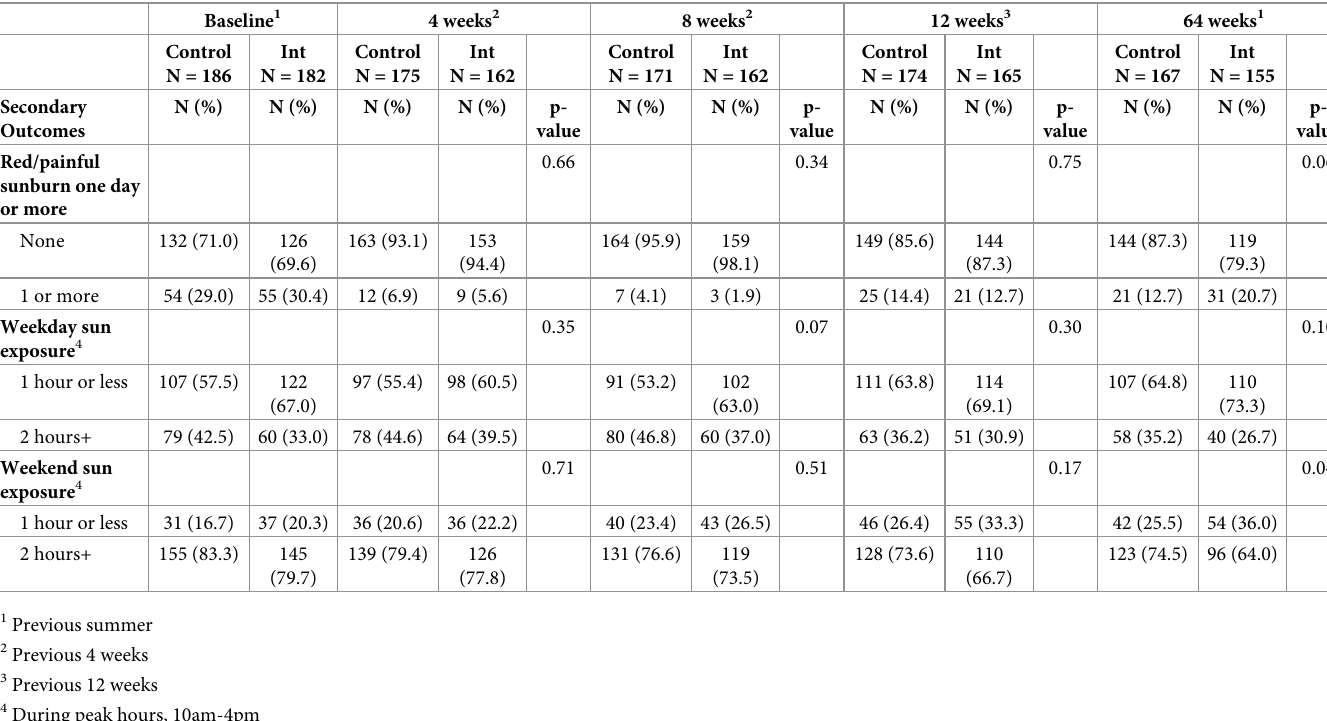
Table 4. Sunburns and participant reported sun exposure at baseline and during the intervention period by MELD randomization group.